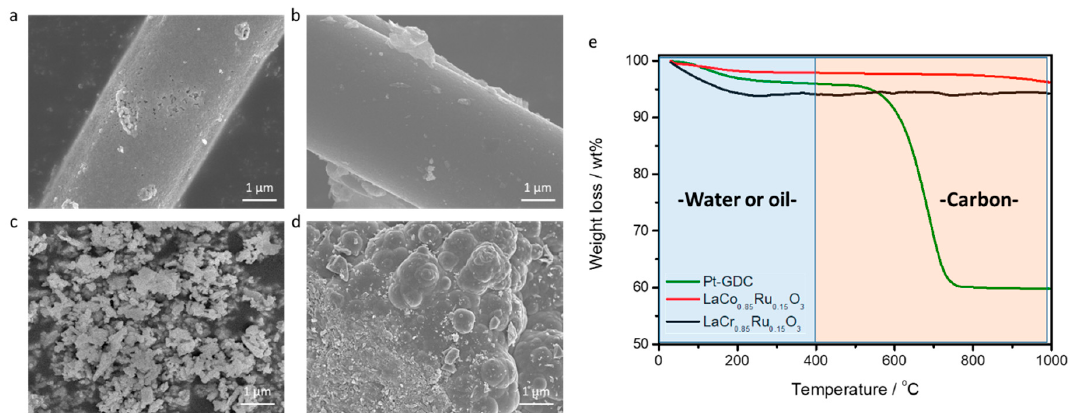
Figure 7. SEM images of used ( a ) LaCr 0.85 Ru 0.15 O 3 , ( b ) LaCo 0.85 Ru 0.15 O 3 catalysts, and ( c ) fresh / ( d ) used Pt-GDC catalyst after LCO-autothermal reforming (ATR) reactions for 25 h, as well as ( e ) TG analysis.